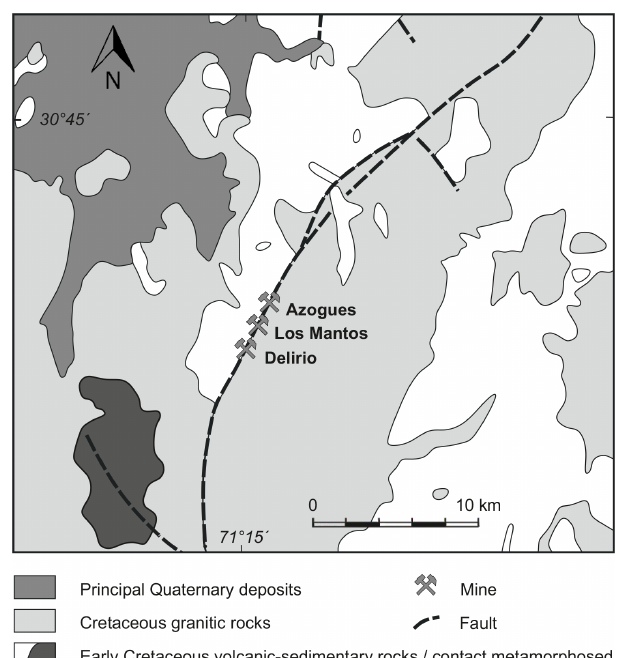
Figure 1. Geological map of the Mantos de Punitaqui district, northern Chile, showing control of the vein by major arc-parallel fault along pluton contact (modified based on Sillitoe and Thomp- son,